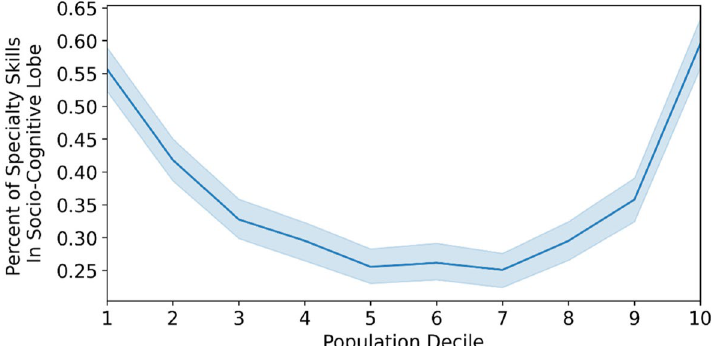
Fig. 4 Share of a County’s Specialty Skills in Socio-Cognitive Lobe by Population Decile. Counties in the lowest and highest deciles have the greatest share of their specialty skills in the socio-cognitive lobes. Moderately urban counties, those in deciles 5, 6, and 7, have the lowest share of their specialty skills in the socio-cognitive